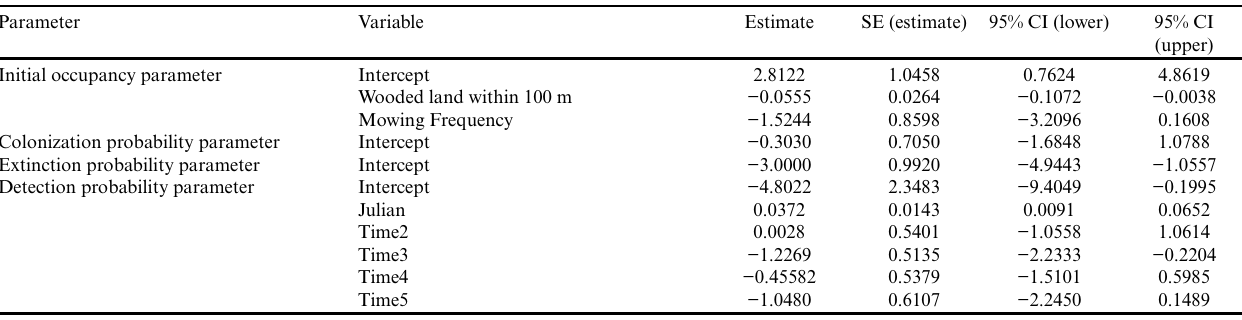
Table 2. Highest ranking multiseason occupancy model for Clay-colored Sparrow along 47 transmission line study sites in Winnipeg, Manitoba, Canada in 2008–2009. AICc = 335.65, Δ AICc = 0.00, AIC weight = 0.37, N = 276 surveys. Total Mackenzie-Bailey chi- square = 13.62 ( P = 0.19), Season 1 = 3.70 ( P = 0.62), Season 2 = 9.92 ( P = 0.06), c-hat = 1.31. Coefficients from other high-ranking models ( Δ AICc ≤ 2.00) are provided in Appendix 3.